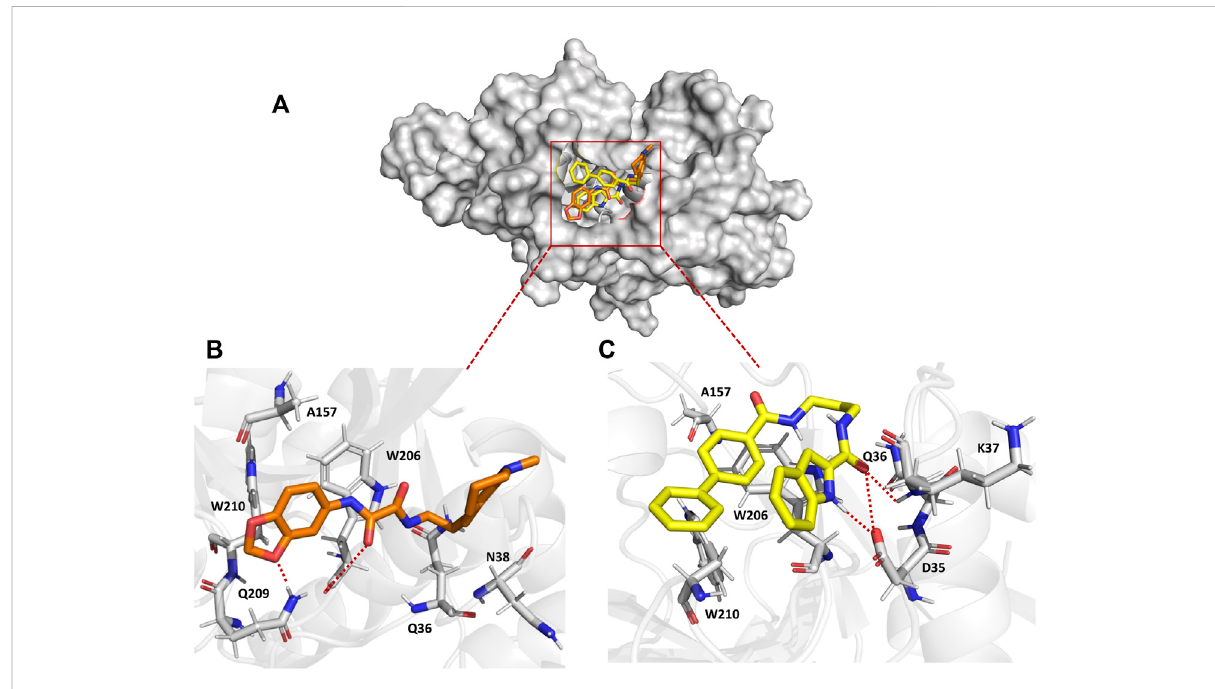
Surfacerepresentation ofQOD (orange)andICD (yellow)boundto theactivesiteofFP-2(gray) (A) .InteractionofQOD (B) andICD (C) withthe active site residues of FP-2. Hydrogen bonds are represented by red dotted